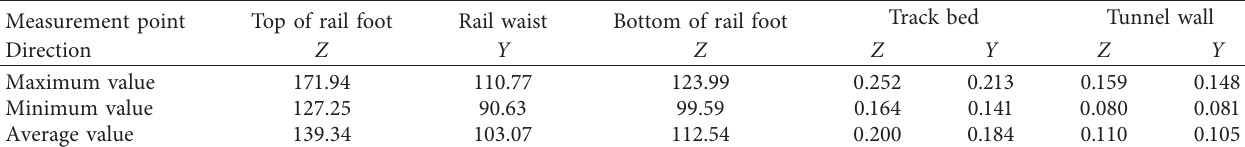
Table 3: Peak accelerations on the track bed and the tunnel wall (unit: m/s 2